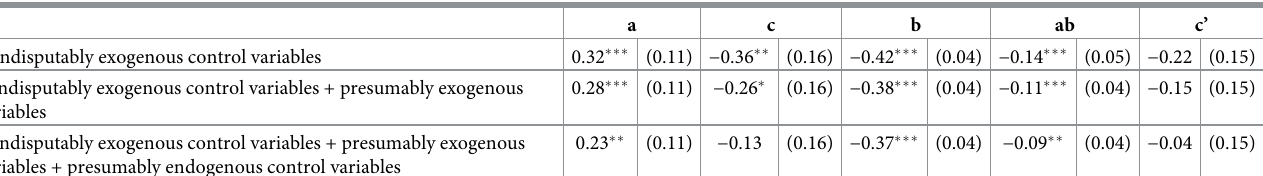
Table 2. Results of the mediation analysis.